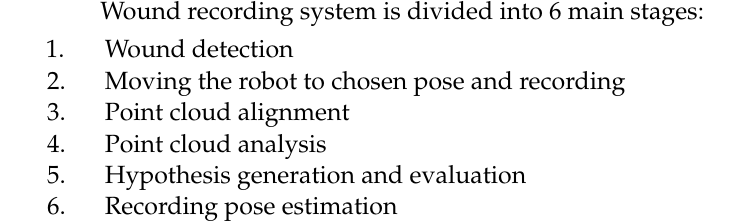
Figure 3. High level concept of the wound recording system.